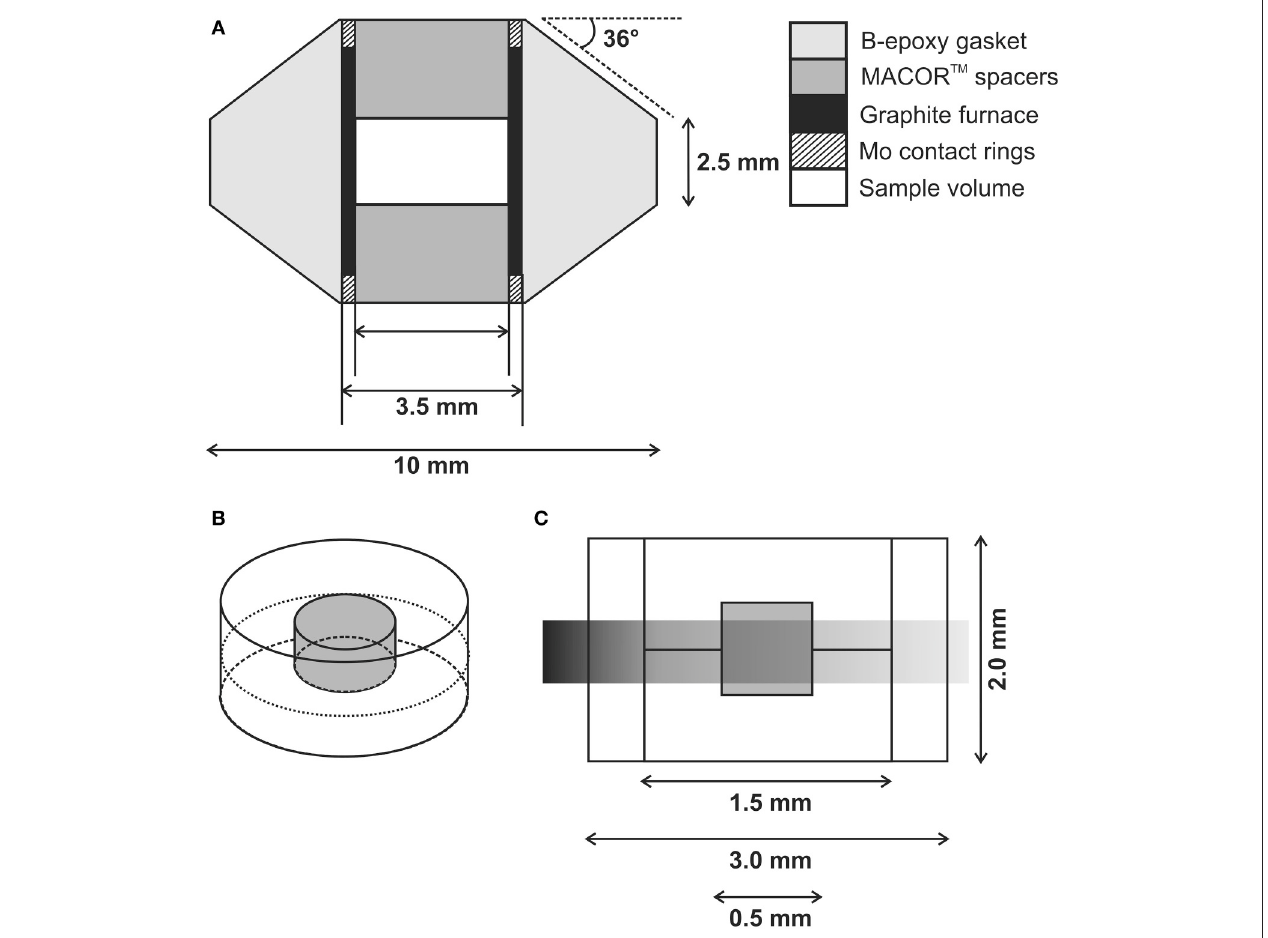
FIGURE 1 | RoToPEc sample assembly. (A) Schematic showing sample assembly, consisting of a shaped boron-epoxy gasket containing integral graphite resistance furnace. (B) 3-D depiction of central sample volume used in melt migration study, consisting of a 2-piece polycrystalline h-BN capsule containing drilled central volume (gray) housing 2-phase mixture of polycrystalline gold and powdered h-BN. (C) 2-D schematic of sample volume shown in (B) with additional outer boron nitride sleeve to aid sample stability at high PT. Gray transparent region represents portions of the sample assembly visible to the X-ray beam, which is otherwise absorbed by the upper and lower carbide